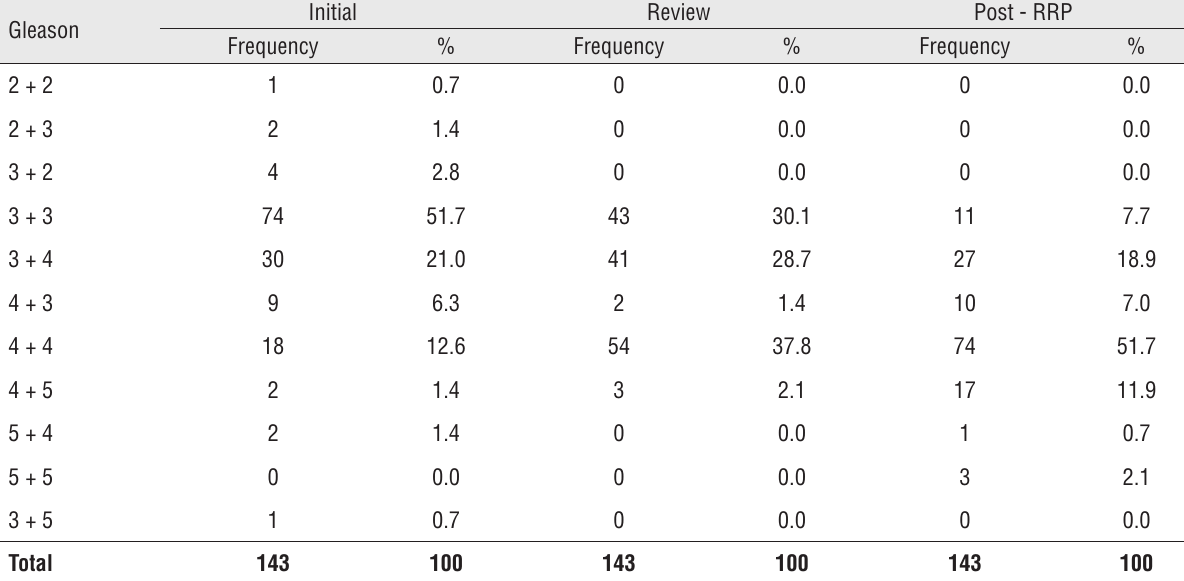
Table 3 - Initial and post - review GS and after RRP only of patients submitted to surgery.